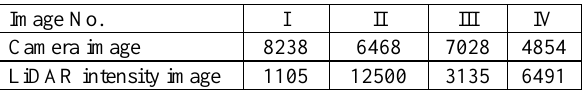
Table 2. Number of SIFT keypoints in images